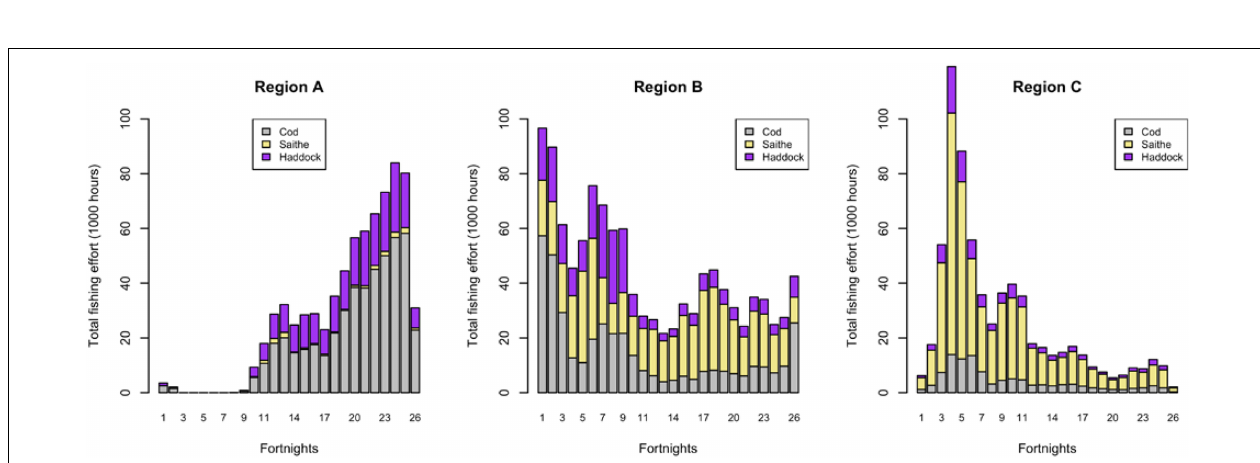
FIGURE 2 | Average of the total catch of the codfish, harvested by trawl fleet, consist of 53 licensed vessels on fortnightly basis in regions A, B, and C over the period of 2011–2016. The total catch is measured in tons of fish. The Norwegian Directorate of Fisheries (Norwegian: Fiskeridirektoratet).